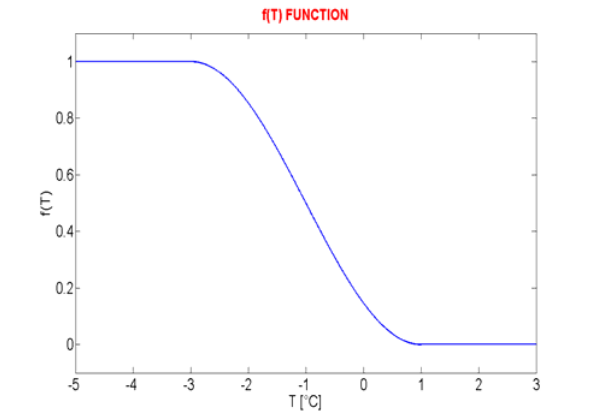
Figure 1. Behavior of the function f(T) in the Viterbo